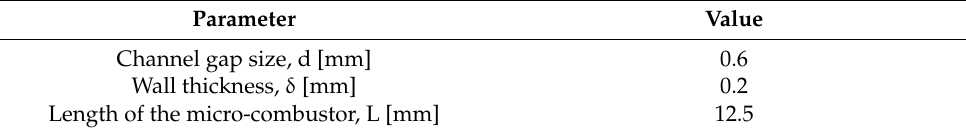
Table 1. Values of the geometrical parameters for the U-bend configuration of Figure